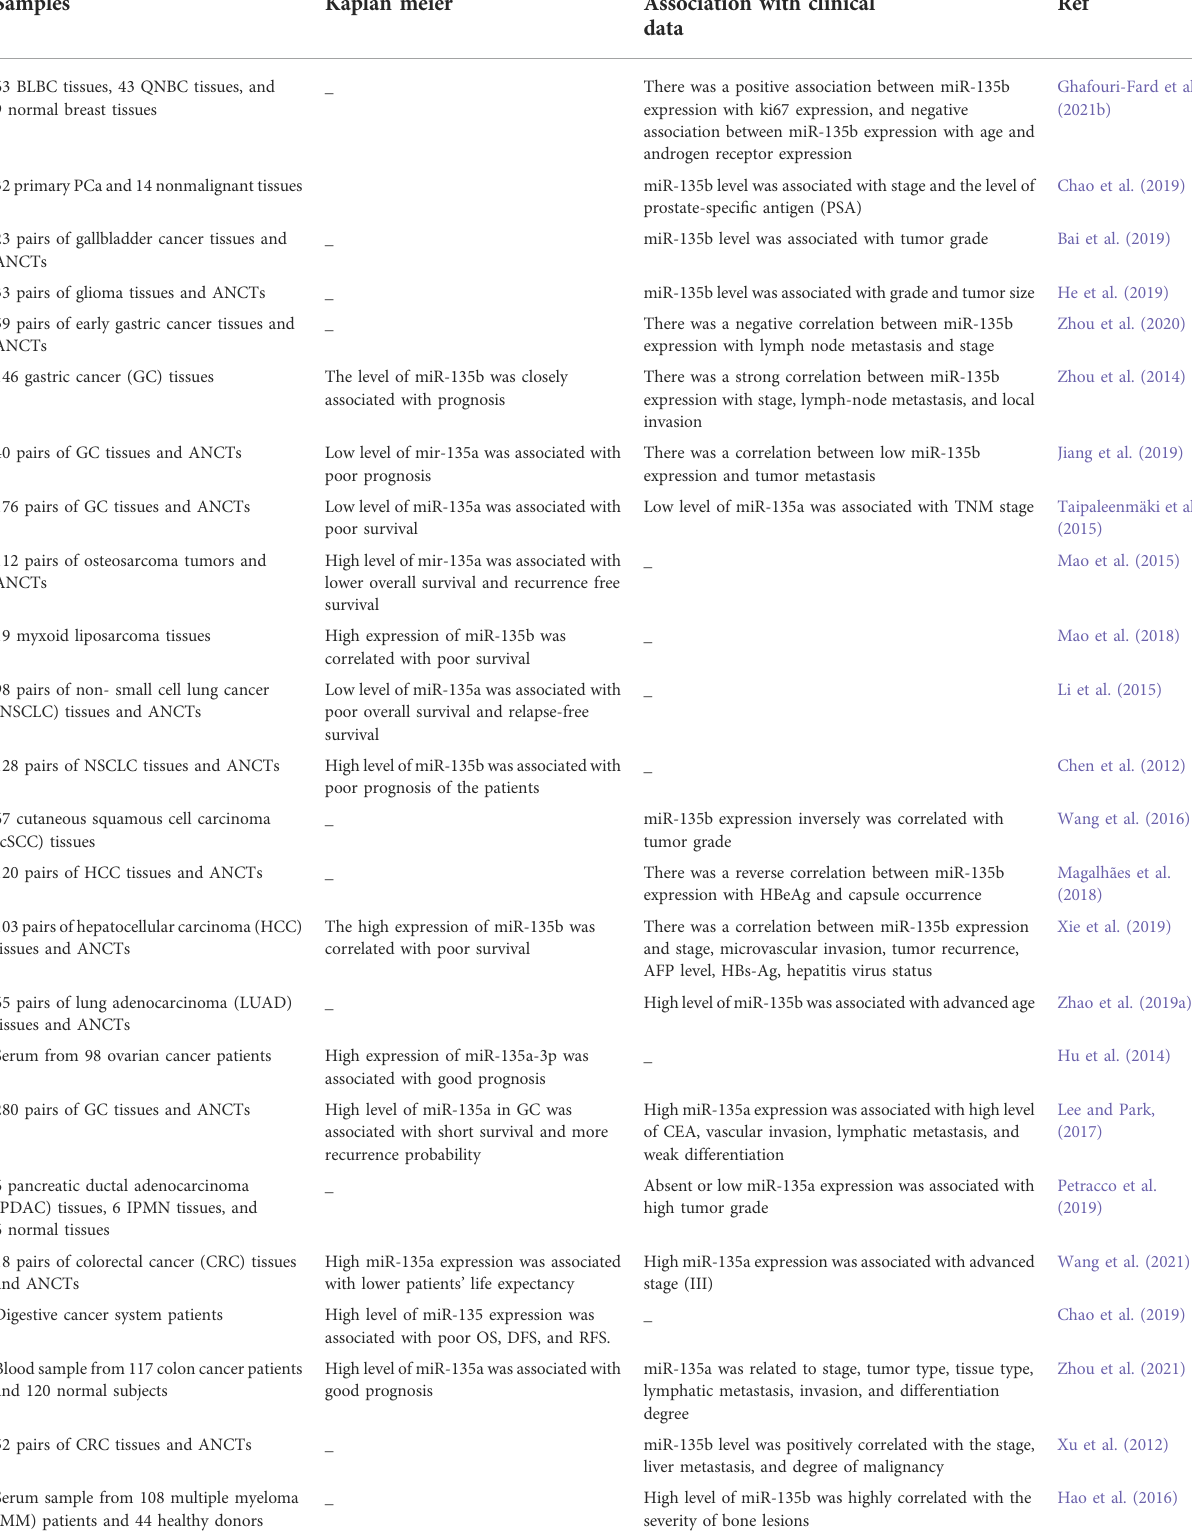
TABLE 2 Prognostic role of miR-135 in the